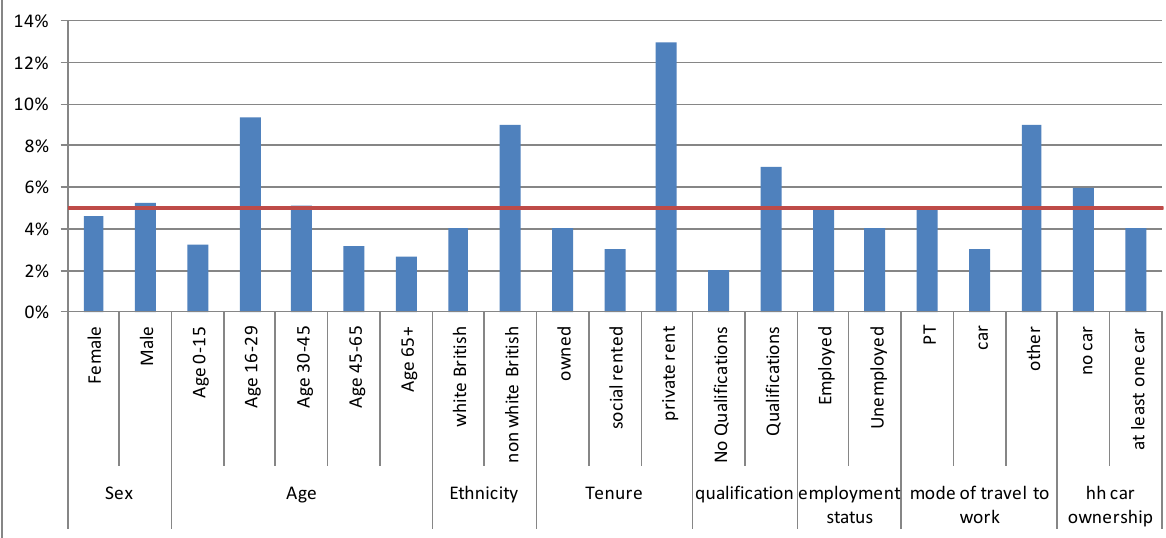
Figure 5. Proportion of the population who can access both bicycle and car share schemes within a 400m walk. to car sharing bays between groups who do or do not have a car. The mean figure for cars per household and per person are both greater for people in areas where share is